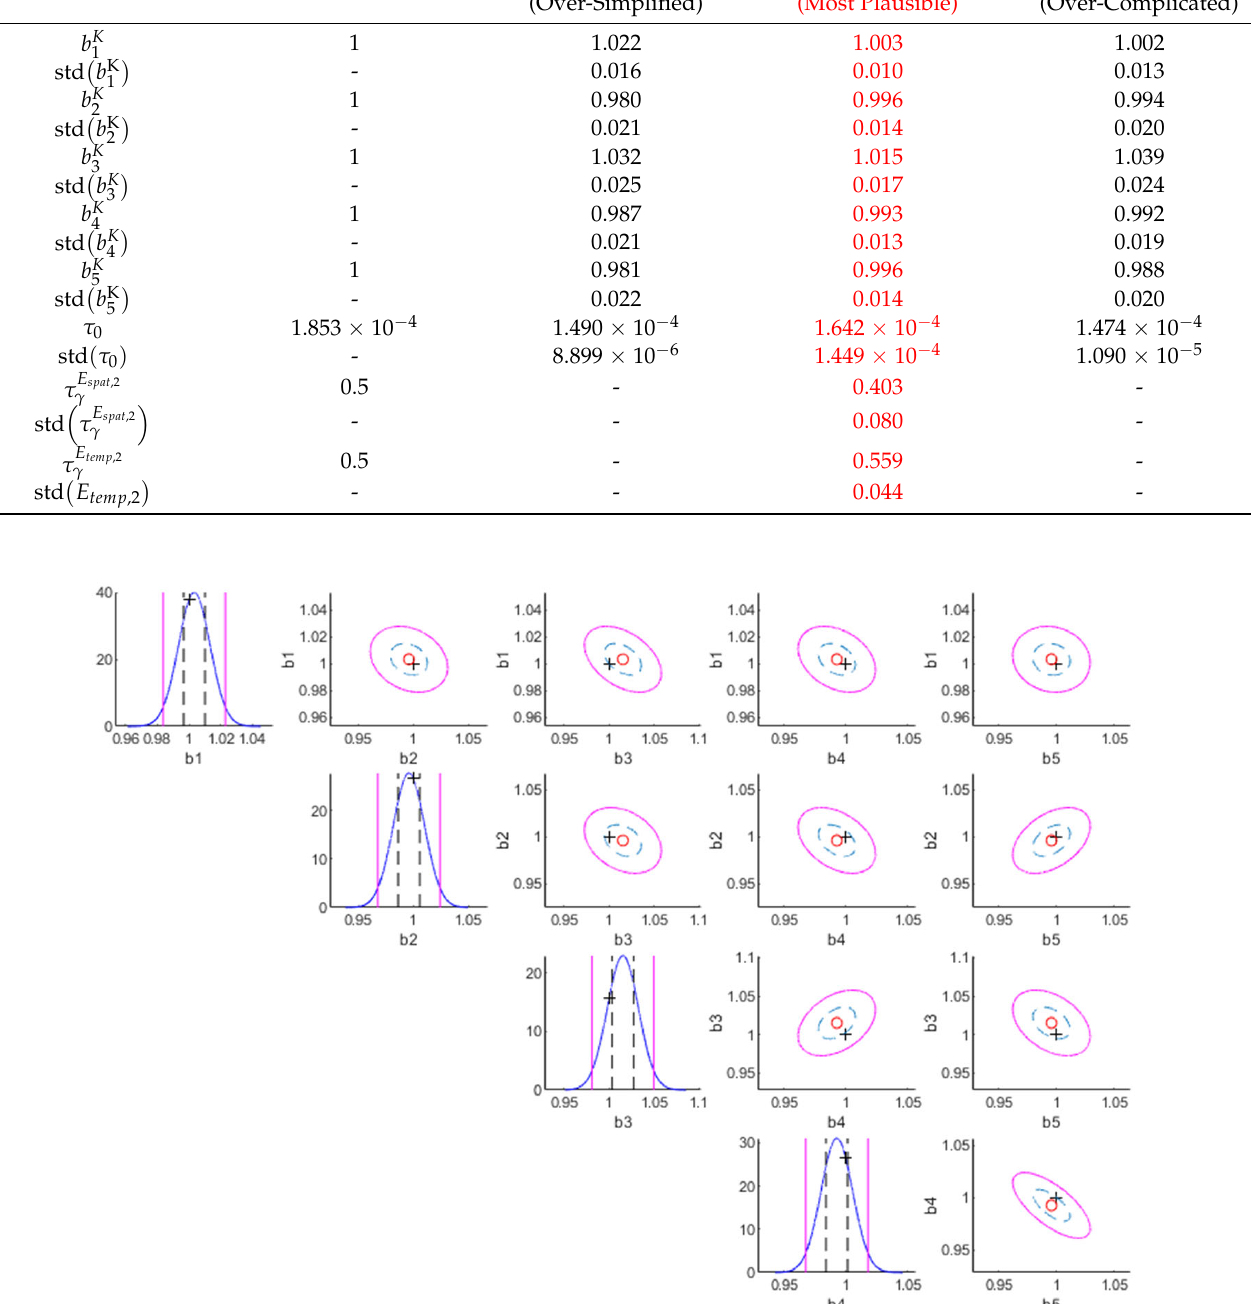
Table 3. Parameter identification results (no damage case).